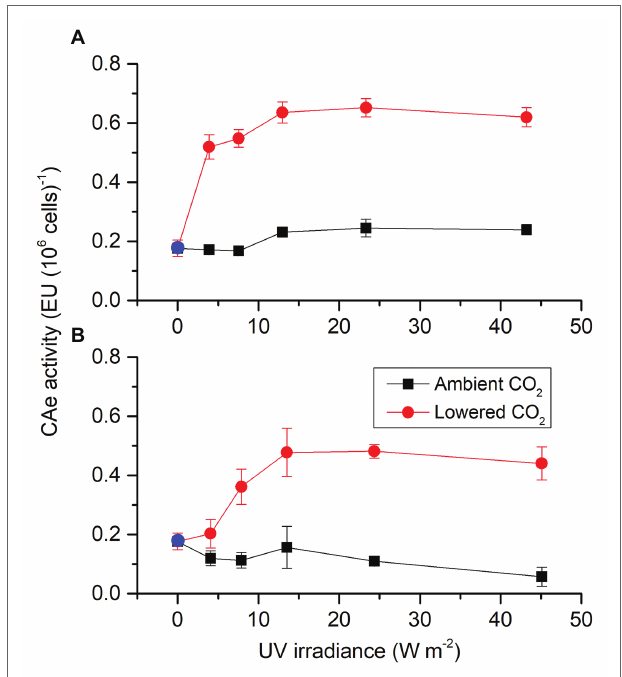
FIGURE 2 | Activity of CAe of S. costatum grown at ambient and lowered CO 2 levels when exposed to UVA (A) or UV radiation (UVR; UVA + UVB; B ). The blue points represent the CA activity of cells cultured at pH 8.20 before exposed to UVR. The error bars indicate the SDs ( n =